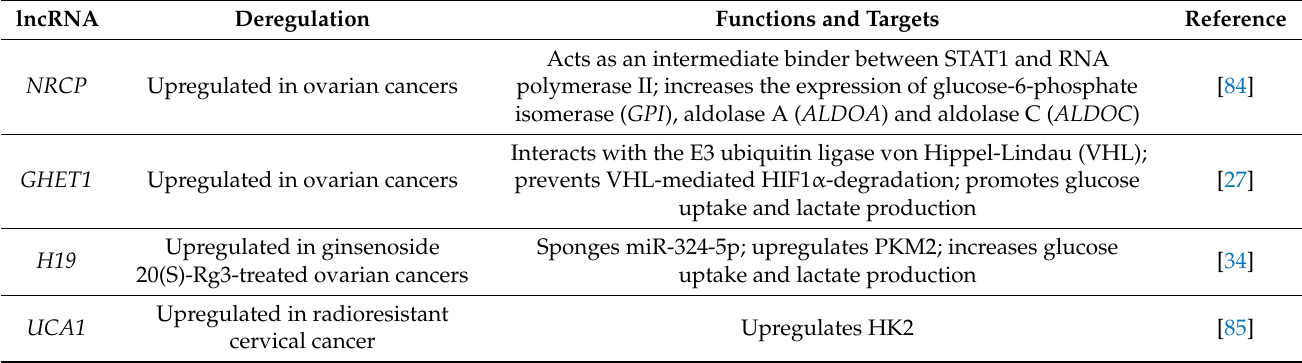
Table 3. Examples of lncRNAs implicated in glucose metabolism alteration in female reproductive system